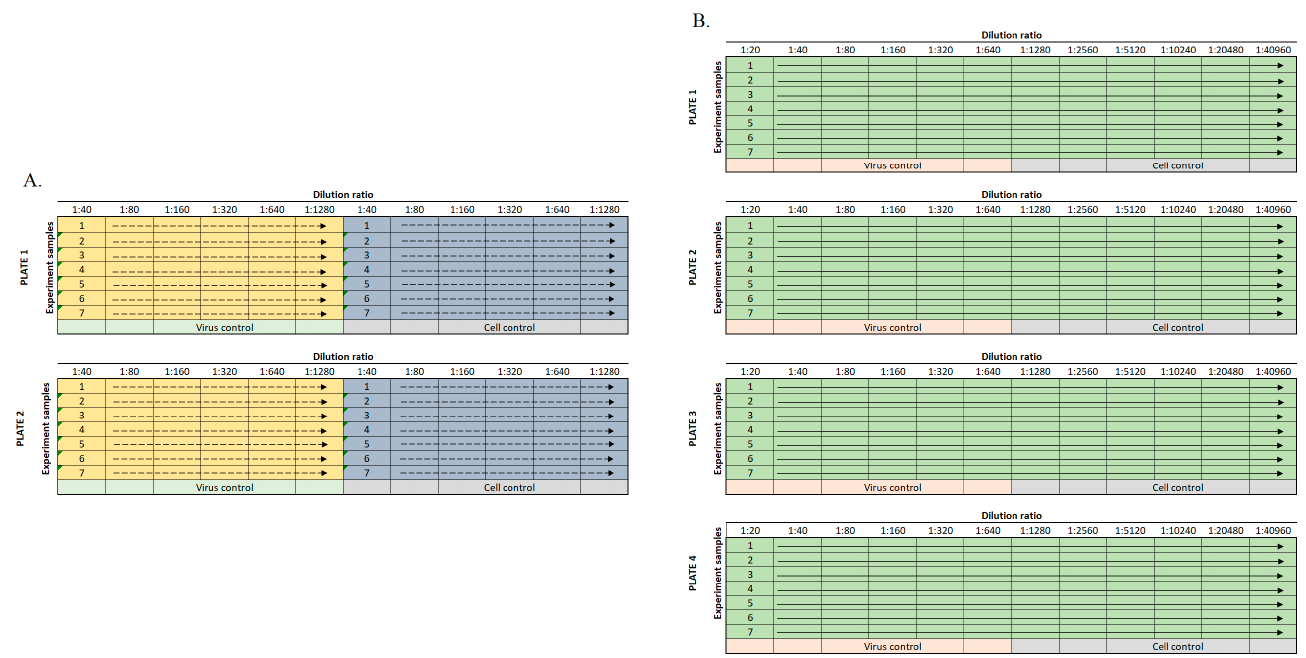
Figure 1. Sample dilution plate map for standard assay. ( A ). Up to seven samples were diluted twice for six dilution points on each plate and run on two duplicate plates. The yellow and blue shading indicate different replicates of each sample tested. ( B ). If more dilution points were required, samples were diluted across the entire plate for 12 dilution points and subsequently run on four plates.